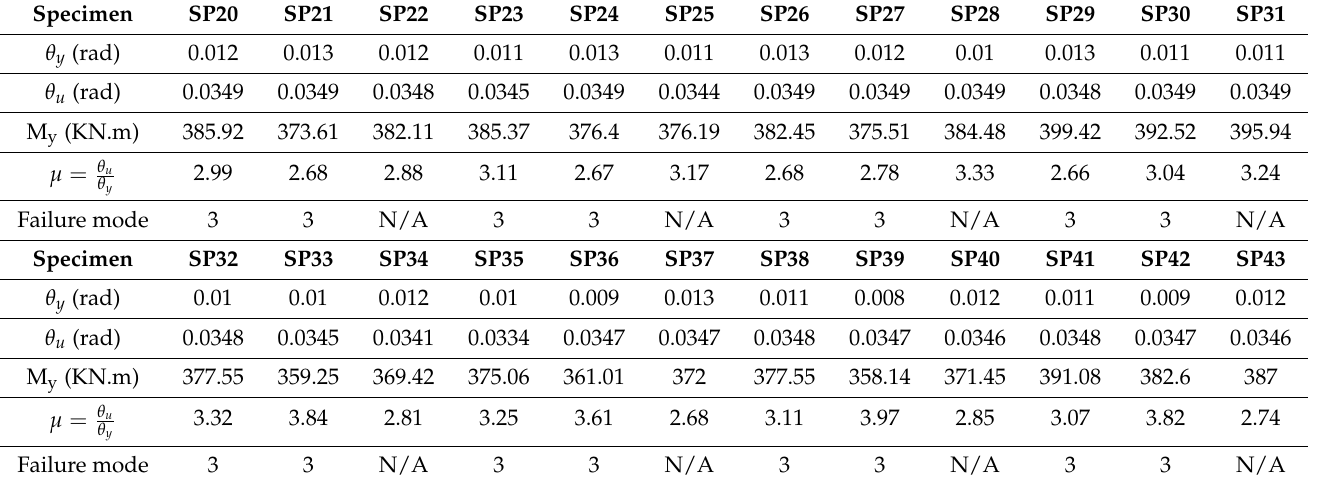
Table 10. Ductility and failure